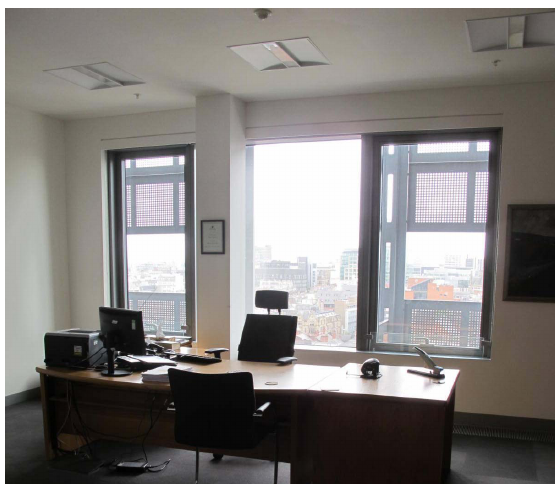
Figure 5. Judge’s Retiring